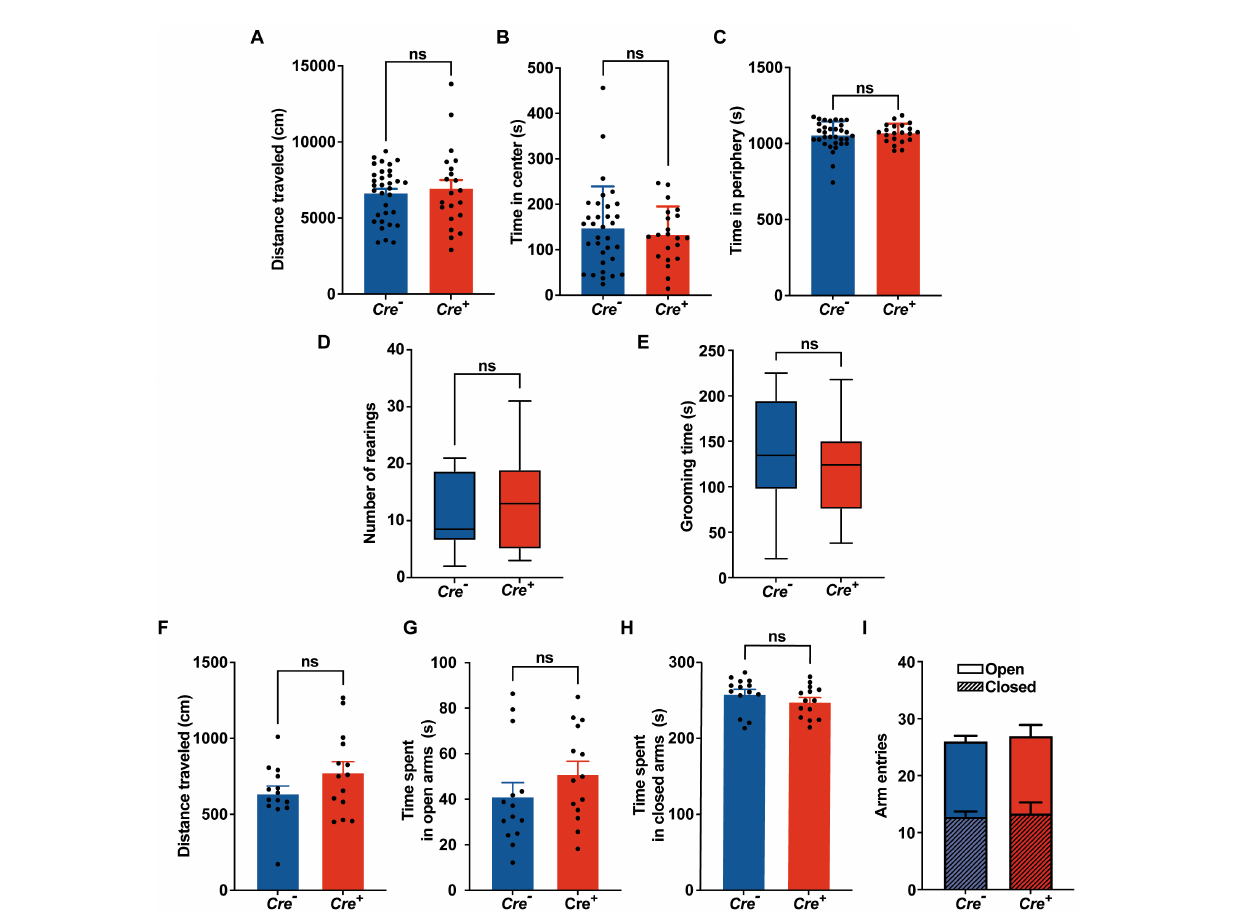
FIGURE 3 Behavioral evaluation of anxiety. (A-C) Open field. (A) Distance traveled in the OF. (B,C) Time spent in the center and in the periphery of the OF measured in Cre − ( n = 33) and Cre + ( n = 21) mice (unpaired t -test). (D) Number of rearings in 10 min observation ( n = 8 for Cre − , n = 7 for Cre + ; Mann– Whitney test). (E) Total time of grooming bouts observed in 10 min ( n = 8 for Cre − , n = 7 for Cre + ; Mann–Whitney test). (F-I) Elevated plus maze ( n = 14 for Cre − , n = 14 for Cre + ; unpaired t -test). Distance traveled (F) , time spent in open (G) and closed (H) arms, frequency of arm entries (I)